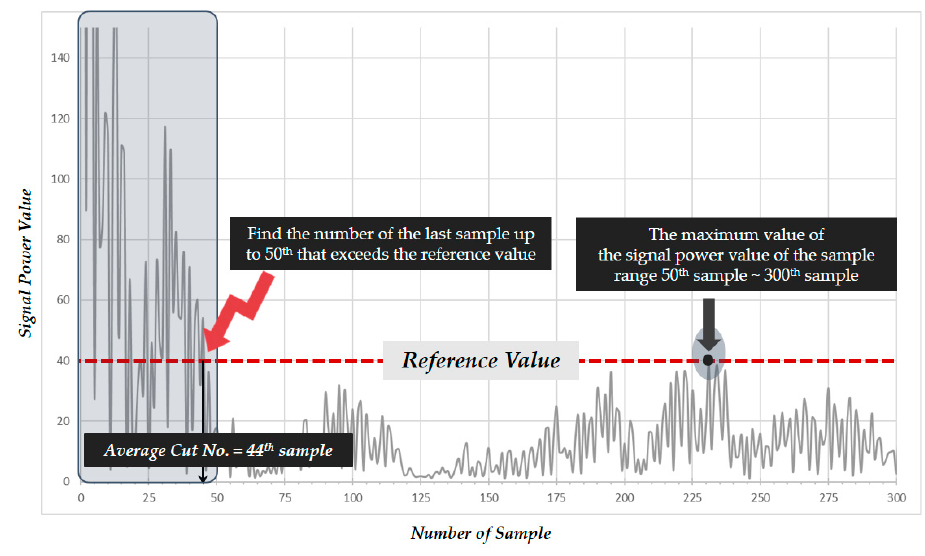
Figure 5. Labeling method considering motion window size and behavior type information.